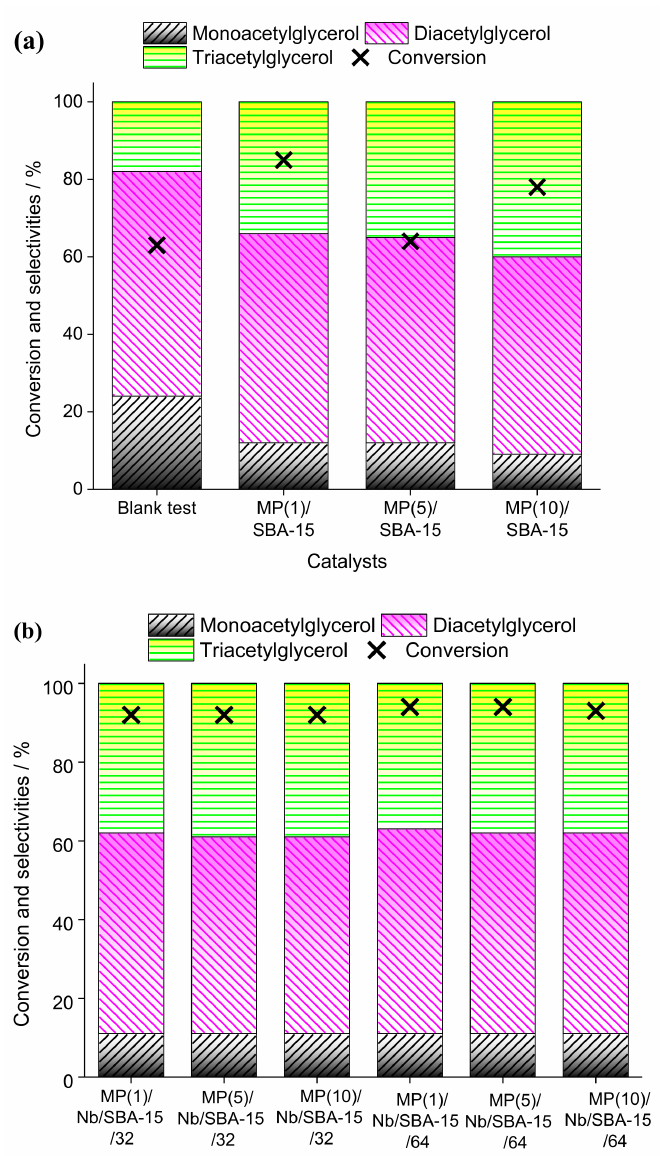
Figure 35. Conversion and selectivities for the glycerol esterification over silicates and Niobium silicates under nitrogen atmosphere, ( a ) over catalysts without Nb and ( b ) over Nb catalysts; 32 or 64 show the TEOS/Nb (tetraethyl orthosilicate/Nb) molar ratios in the synthesis of gel; (1), (5), or (10) show the Si/MP (MP = (3-mercaptopropyl)trimethoxysilane) molar ratios, and SBA-15 is the mesoporous molecular sieves. Reaction conditions: molar ratio glycerol:acetic acid (1:9), catalyst (100 mg), temperature (150 ◦ C), time (4 h) (adapted from